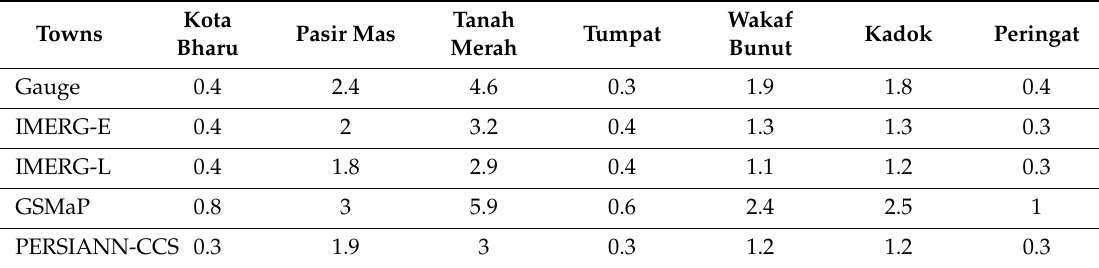
Table 3. Comparison of flood depth at di ff erent towns using hydrological model using di ff erent satellite precipitation products and rain gauge data.